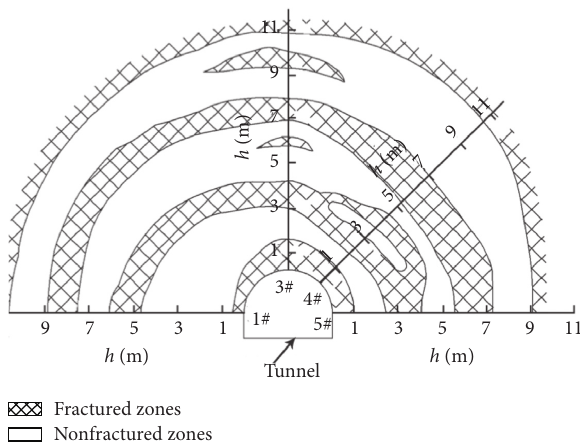
Figure 1: Zonal disintegration of Oktyabrskil mine in Russia.